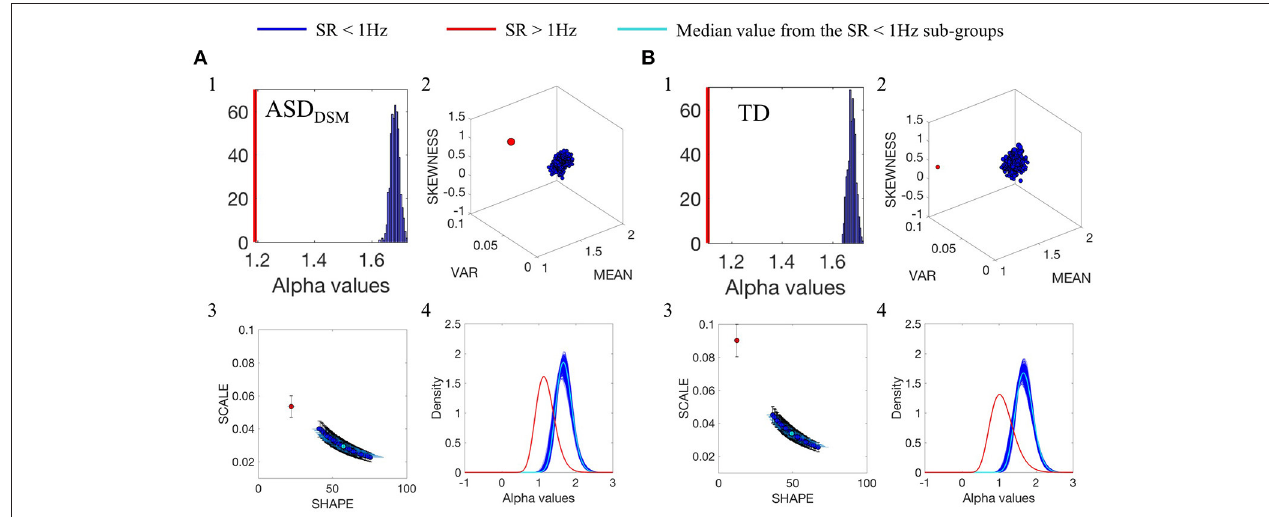
FIGURE 3 | Comparison between the distributions of α values of the linear speed for the groups with different original SR. (A1) Frequency histogram of the mean α values from the 500-sub-groups extracted from ASD DSM participants from SR0 group (large group) using bootstrapping, compared with the mean of 44 ASDDSM participant from SR1 group (small group, represented by the red vertical line). (A2 ) Empirically estimated Gamma moments (marker size is the kurtosis). Red dot is estimated from the ASD DSM -SR1smaller group. Blue cluster is the ASD DSM -SR0 large group with 500 sub-groups built using bootstrapping method described in Figure 3 while preserving the age binning composition of each sub-group to match that of the small group. (A3) Estimated points on the Gamma parameter plane with 95% confidence intervals. Red point is the ASD DSM -SR1 small group while blue dots are from the ASD DSM -SR0 500 subgroups from the large group. Cyan is the median value. (A4) PDFs obtained from the estimated shape and scale Gamma parameters. (B) TD group participants with similar format as (A) .